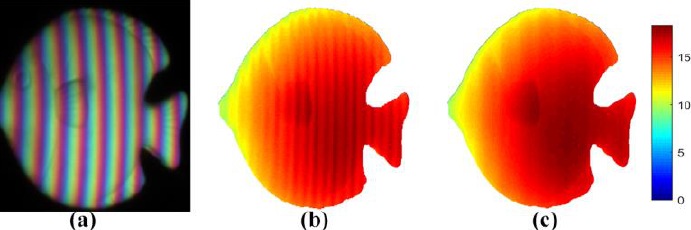
Figure 11. Results of a white fish: ( a ) captured image of the fish; ( b ) the absolute phase without corrections; and ( c ) the absolute phase obtained the proposed method. Unit: rad.